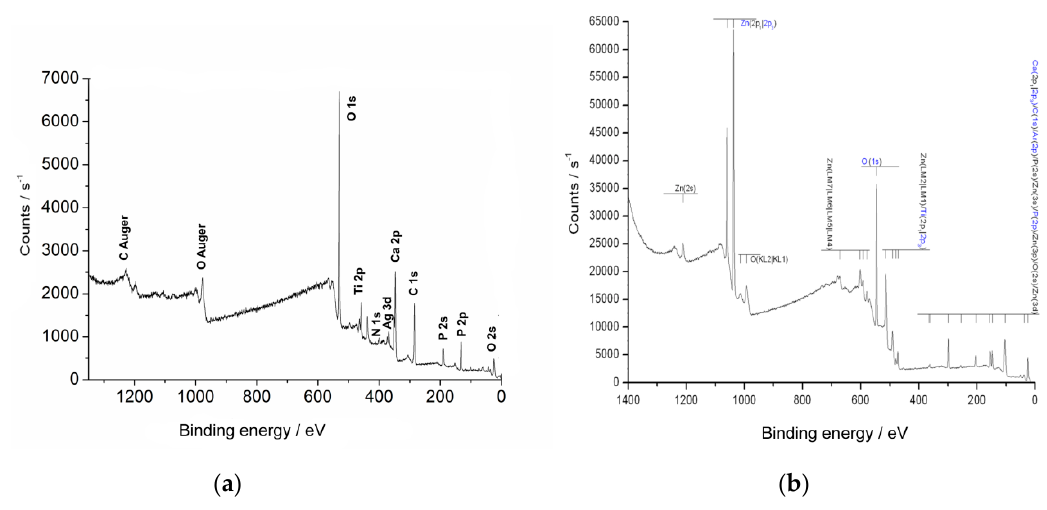
Figure 3. X-ray photoelectron spectroscopic analysis: ( a ) TiOB ® SiOx Ag; ( b ) TiOB ® Zn.